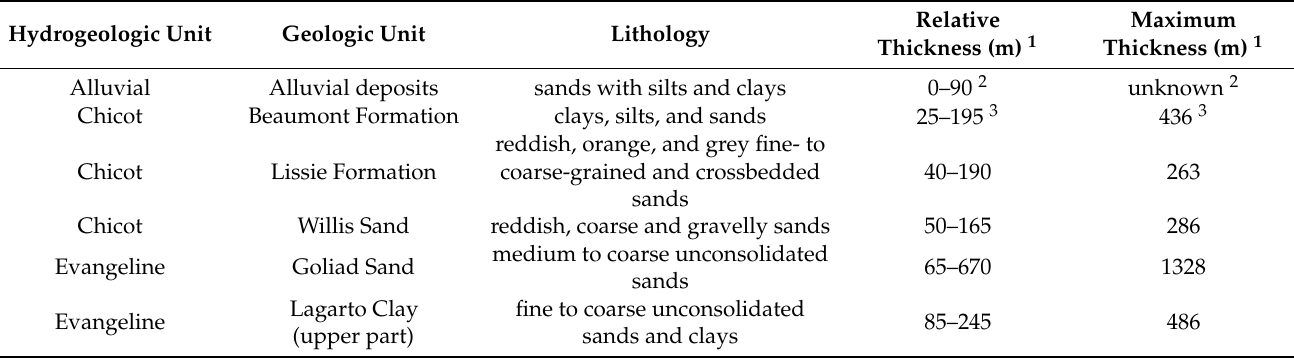
Table 2. Hydrogeologic and geologic units, lithology, and thicknesses of the units that comprise the Gulf Coast aquifer system in the Texas Coastal